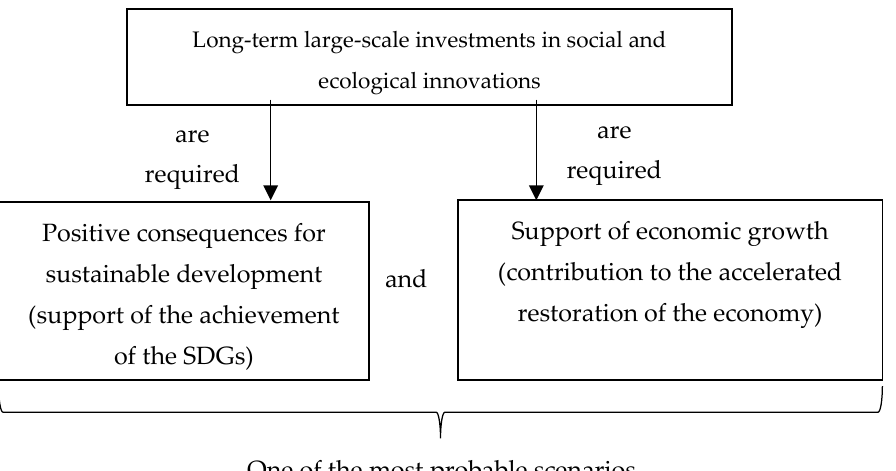
Figure 5. Consequences of investments according to the new (alternative) approach to financial risk management amid the economic crisis, which is based on corporate social responsibility. Source: authors.